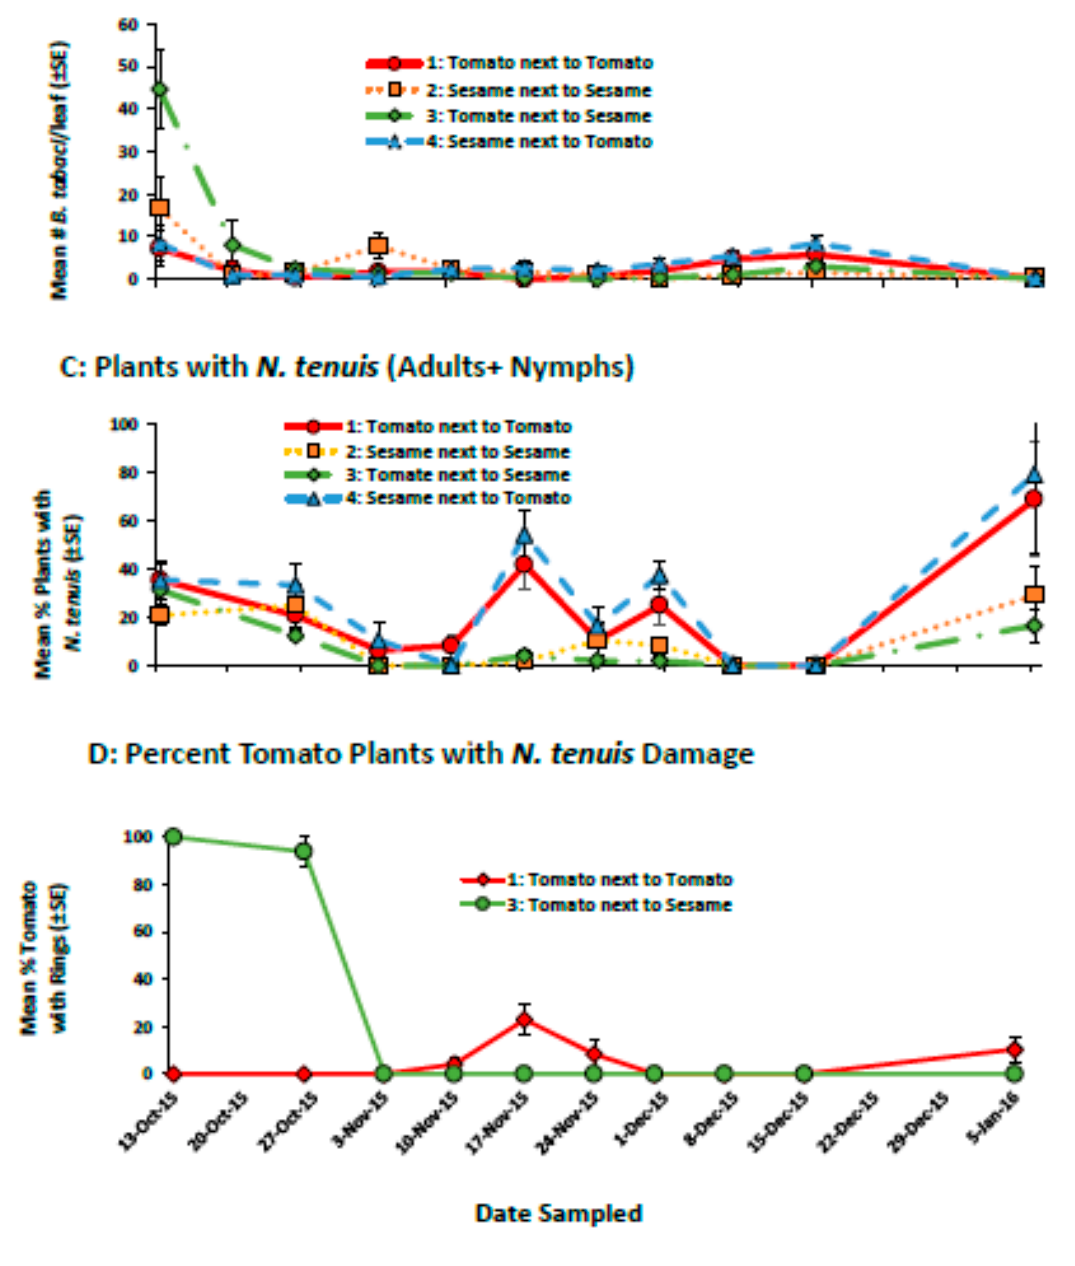
Figure 2. The field plot layout ( A ), the mean (±SE) number of B. tabaci (eggs + nymphs) per leaf ( B ), the mean (±SE) percentage of plants with N. tenuis (adults + nymphs) ( C ), and the mean (±SE) percentage of tomato plant with N. tenuis damage (necrotic rings) ( D ) in a study that compared the ability of sesame alone and inter-planted with tomato to retain N. tenuis and to control B. tabaci . The number under each field plot treatment ( A ) indicates the number of tomato and sesame plants.